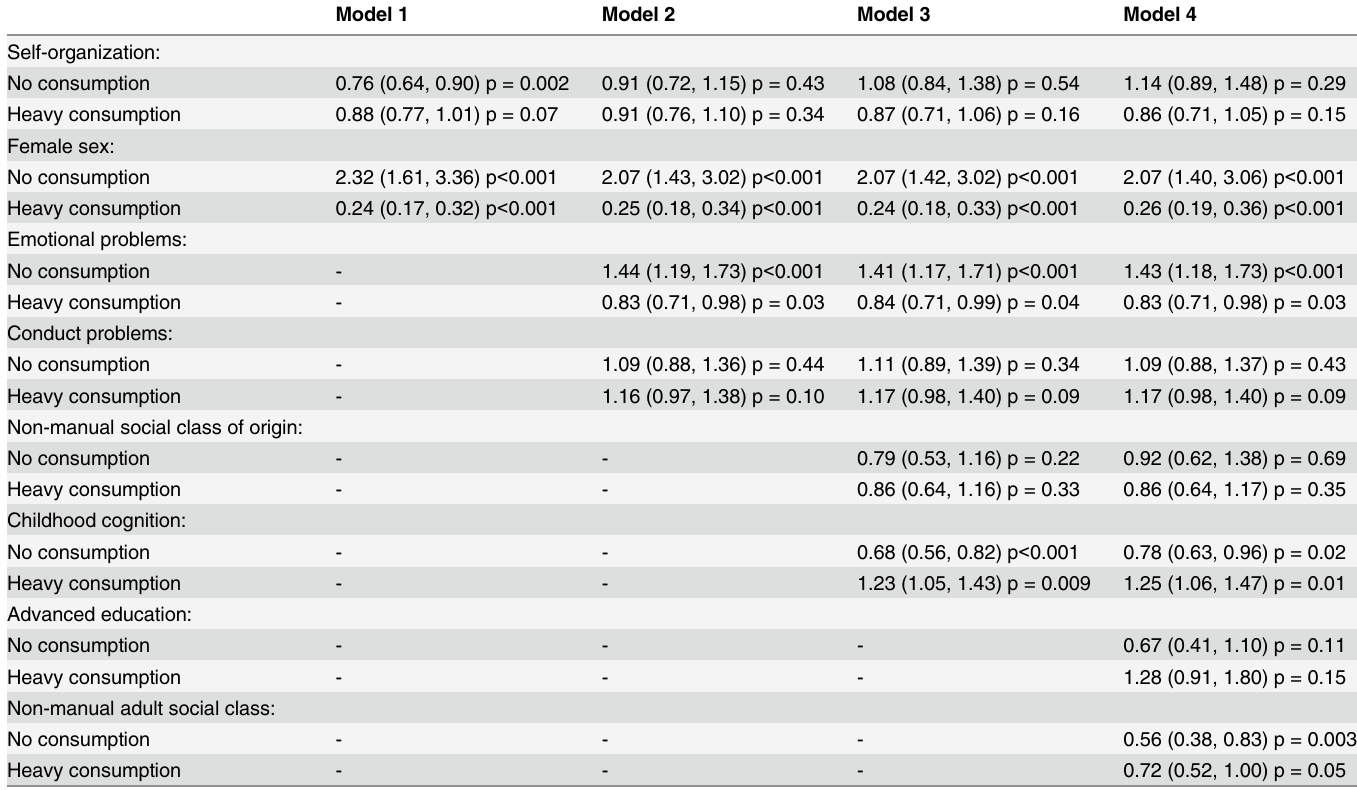
Table 3. Multinomial logistic regression coefficients for odds of abstention and heavy alcohol consumption across adulthood (ref. = light to